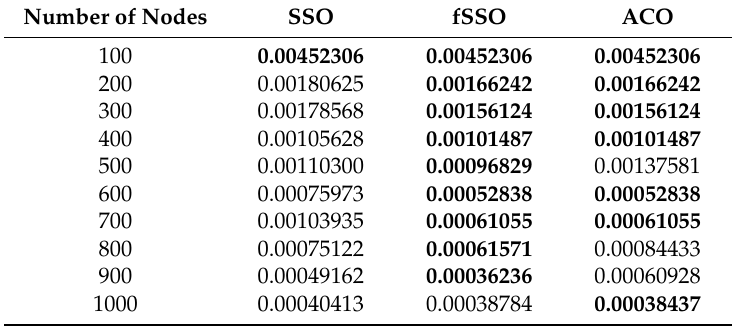
Figure 10. Standard deviation of the fitness values for ten benchmarks.